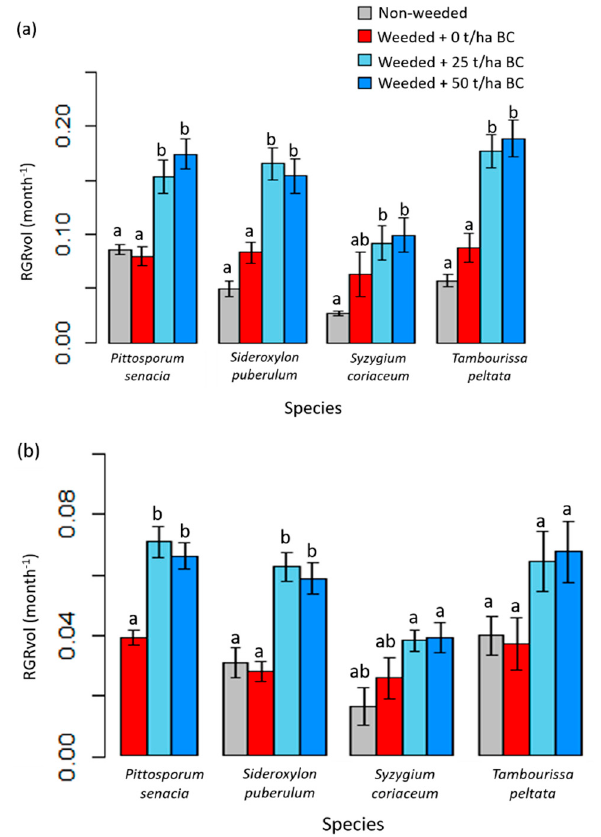
Figure 2. Relative growth rate (RGRvol) by treatment of P. senacia , S. puberulum , S. coriaceum , and T. peltata after 6 months ( a ) and 30 months ( b ). Weeding (strawberry guava removal) and biochar treatments at rates of 0, 25, and 50 t/ha are compared to the non-weeded control. Means are plotted as ± 1 SE; differences significant at p < 0.05 (Tukey HSD post hoc tests) are indicated by different